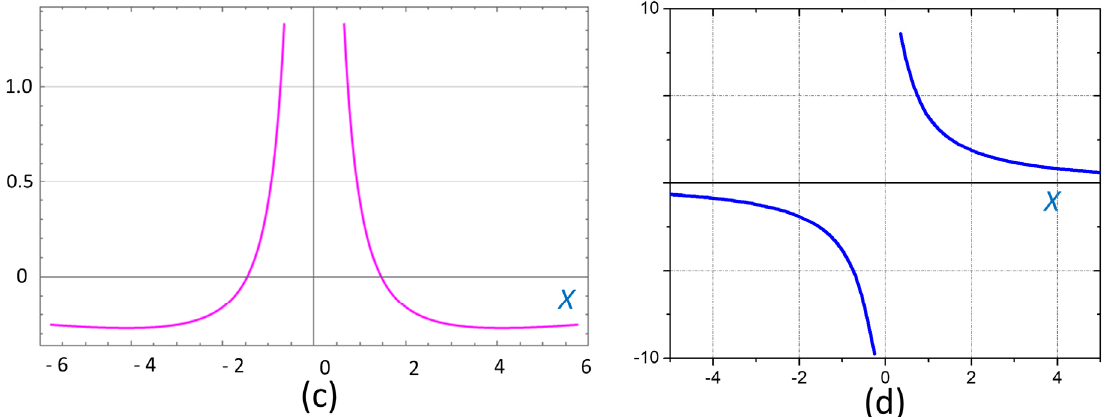
Figure 11. Calculated magnetic field strength components and their derivatives: ( a ) H z /M , ( b ) H x /M , ( c ) ( dH z /dx ) M −1 , and ( d ) ( dH x /dx ) M −1 (both derivatives are in mm − 1 ), versus the x- coordinate (in mm ) The calculations were made in the plane 0.2 mm above the surface of the magnets. Note, x = 0, the origin of the coordinate system, is in the center of the magnetic system.